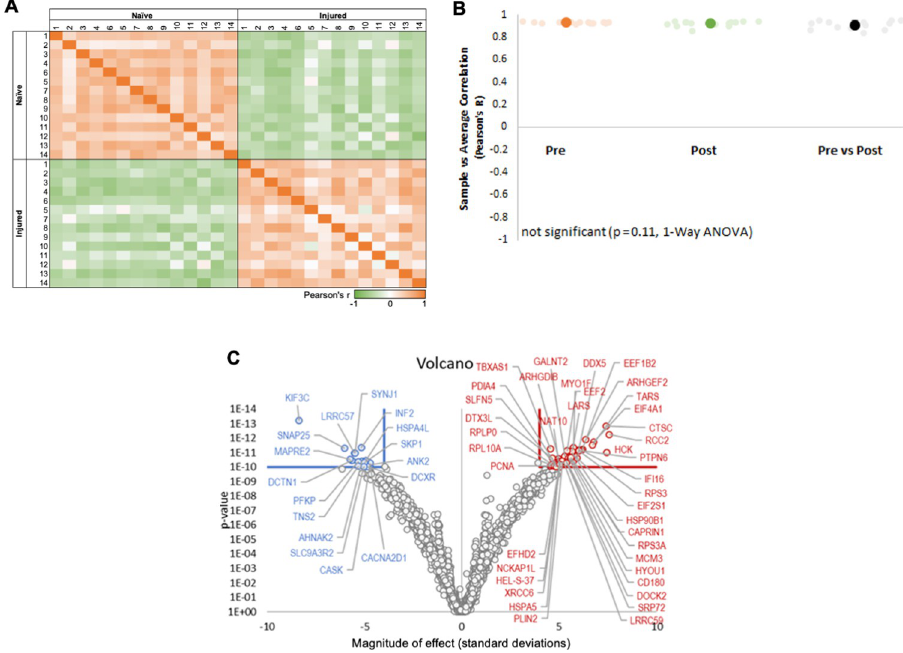
Fig 4. Clear Proteomic Changes Between Na ï ve and Injured Nerve. A. Overall proteomic expression was altered after nerve injury based on Pearson r correlation. The Pearson’s correlation R-value for each sample, correlated with every other sample is displayed in a correlation matrix of na ï ve and injured samples (matrix scale orange R = 1: Perfect correlation, green R = -1: Perfect anti-correlation). B. Lin’s CCC demonstrated strong homogeneity among samples within the pre- and post-injury groups C. The volcano plot shows proteins that were downregulated (blue) and upregulated (red) after injury. For the volcano plot, the p-value cutoff was 1E-10 and the Z (Log2(FC)) cutoff (log2 scale) was